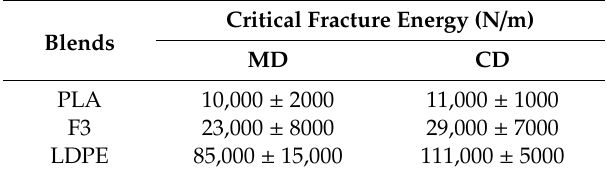
Table 9. Results of the trouser tear tests